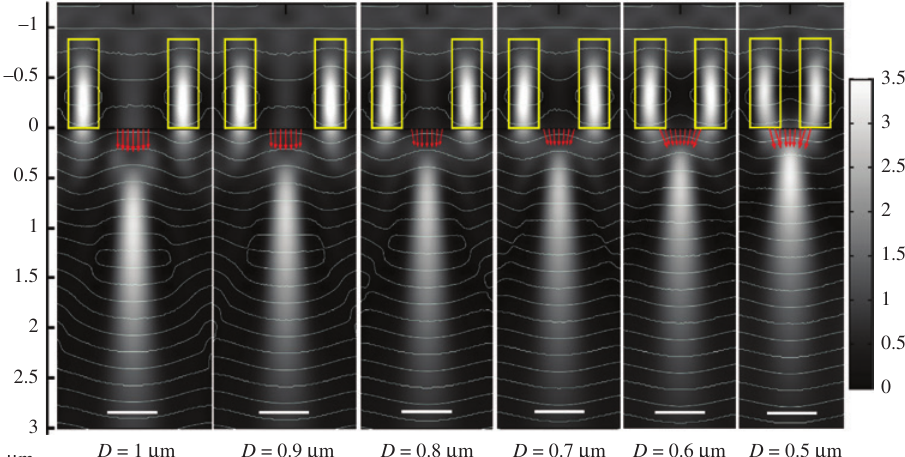
Figure 4: Diffraction intensity patterns generated by pairs of dielectric rectangles (W = 0.3 μ m, H = 0.9 μ m, n = 1.52) for separating distances D = 1 μ m, 0.9 μ m, 0.8 μ m, 0.7 μ m, 0.6 μ m, 0.5 λ . The scatterers are in air and focalization occurs in the dielectric (n = 1.52). The scale bar corresponds to a length 0.5 μ m, i.e. it λ for the wavelength 0.5 μ